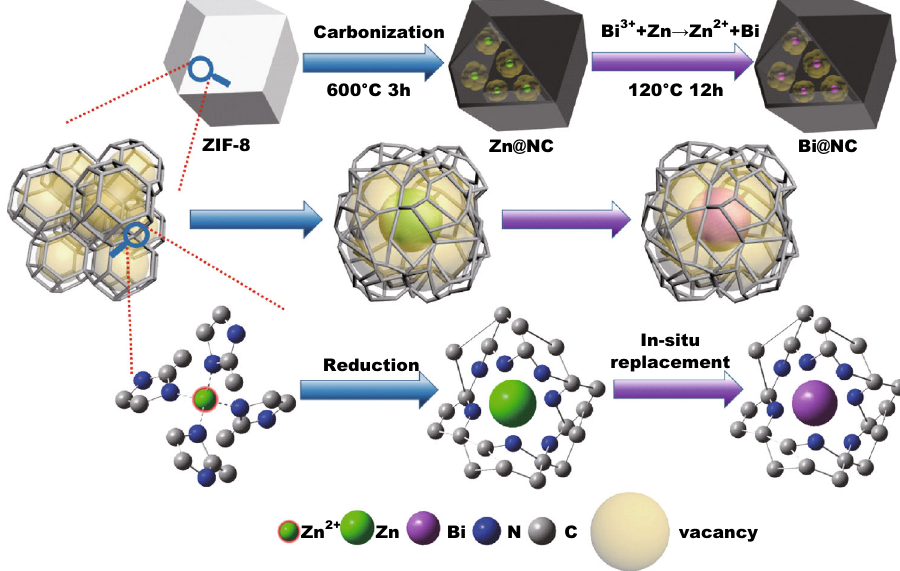
Fig. 2 Schematic illustration of the formation process of